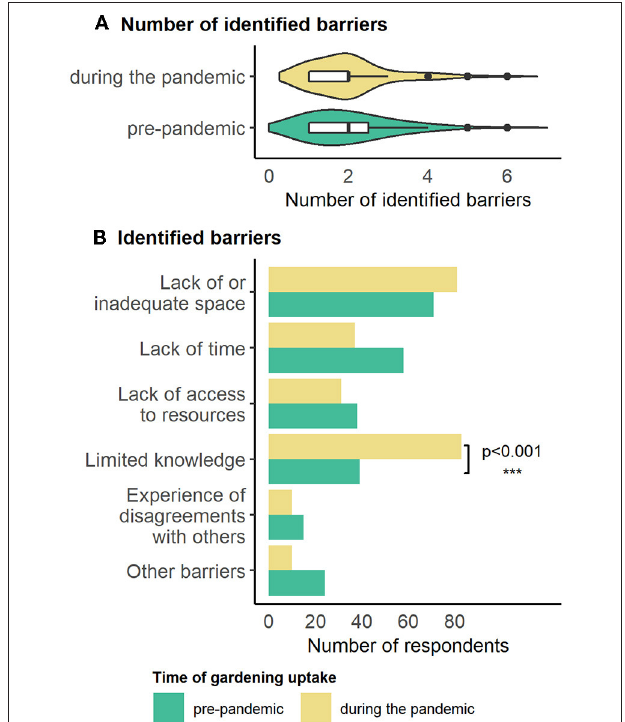
FIGURE 5 | (A) Number and (B) type of barriers identified by the respondents. Significance level indicated by *** p < 0.001. For details on the test statistics, see Supplementary Table 3